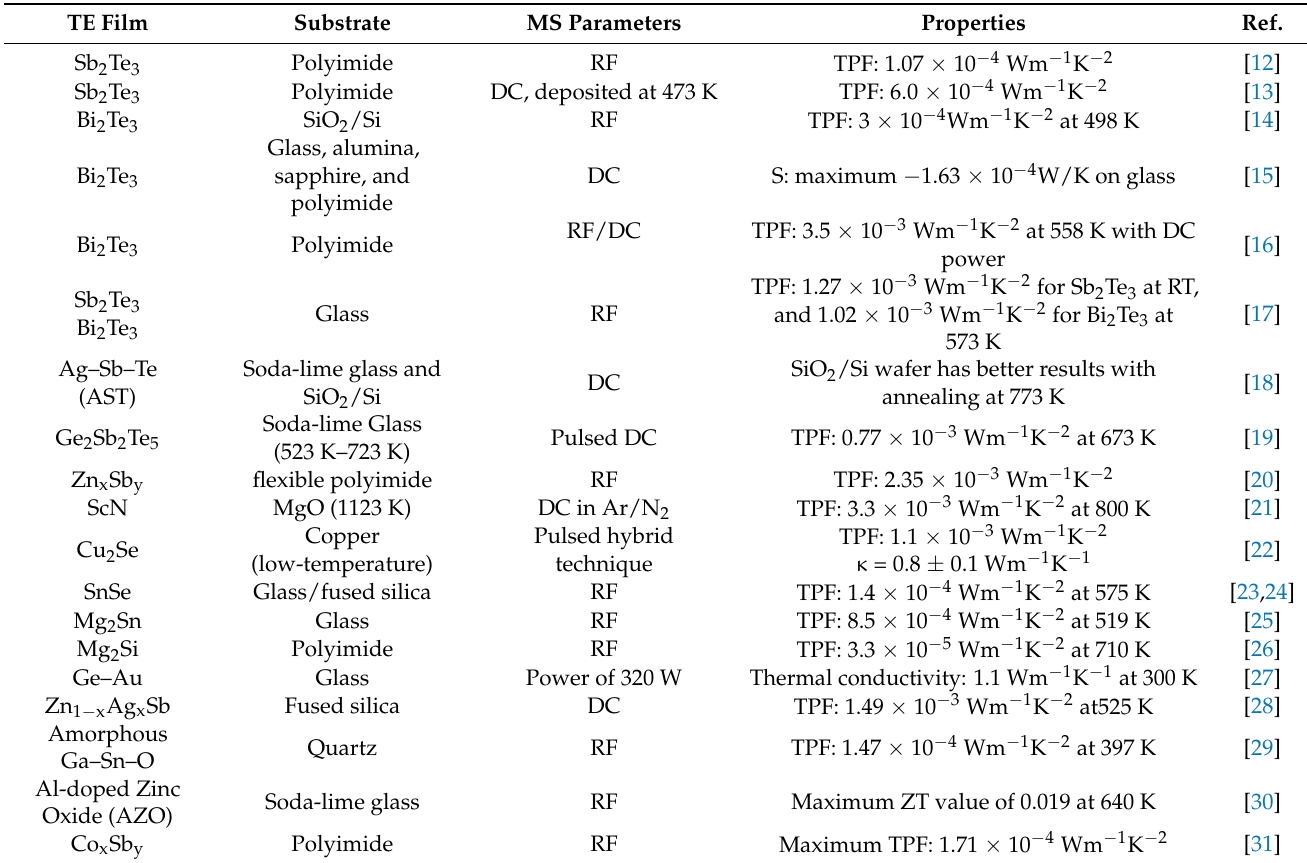
Table 1. Thermoelectric films produced by magnetron-sputtering